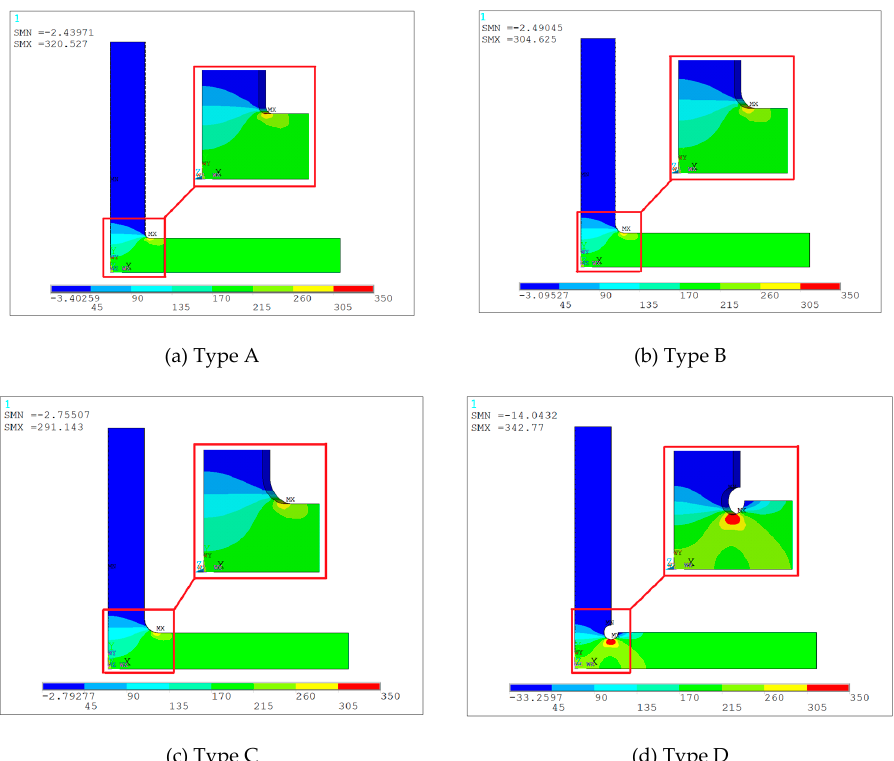
Figure 6. Horizontal stress distribution in specimens type A, B, C, and D ( n = 0, σ (cid:2868) = 200 MPa).